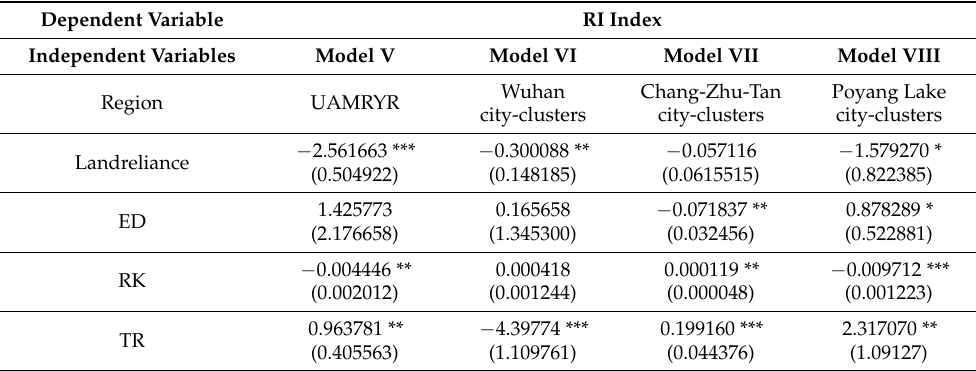
Table 3. Estimated results for Landreliance as the dependent